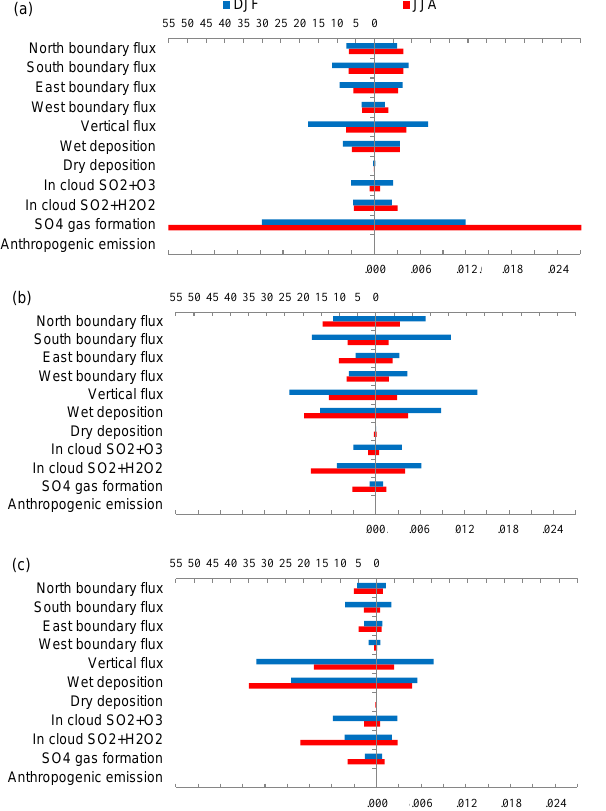
Figure 10. The MAD (TgSseason − 1 , right) and relative contribu- tion (%, left) of each sulfate process (flux) in (a) NC, (b) SC, and (c) SCB obtained from simulation ANNmet. Blue lines are for DJF and red lines are for JJA. Transport fluxes were calculated at the bound- aries while other sources and sinks were calculated as the sums over the grid cells of the region under 1km.